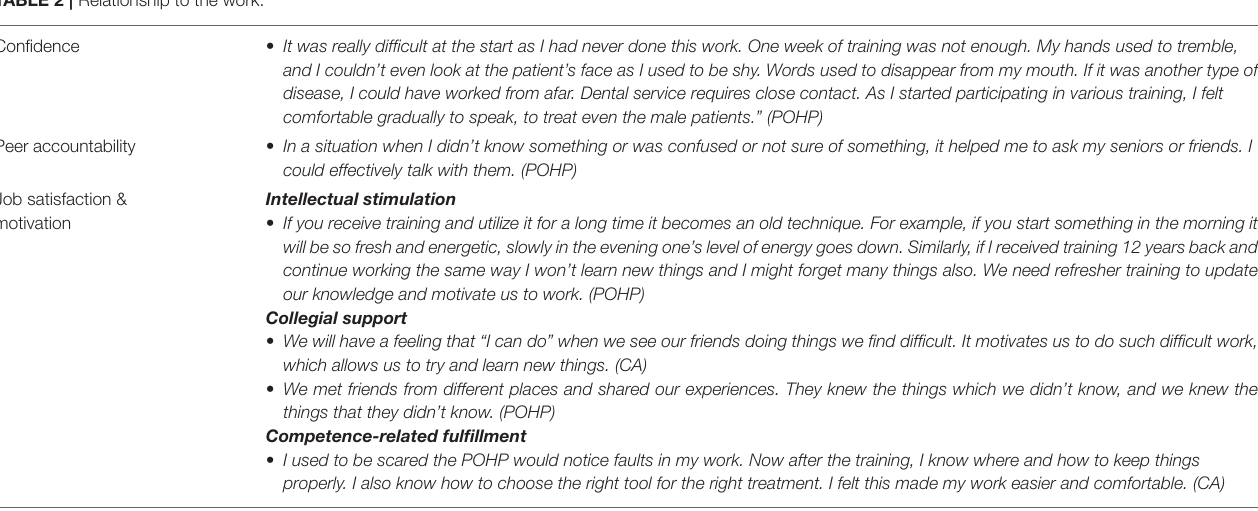
TABLE 2 | Relationship to the